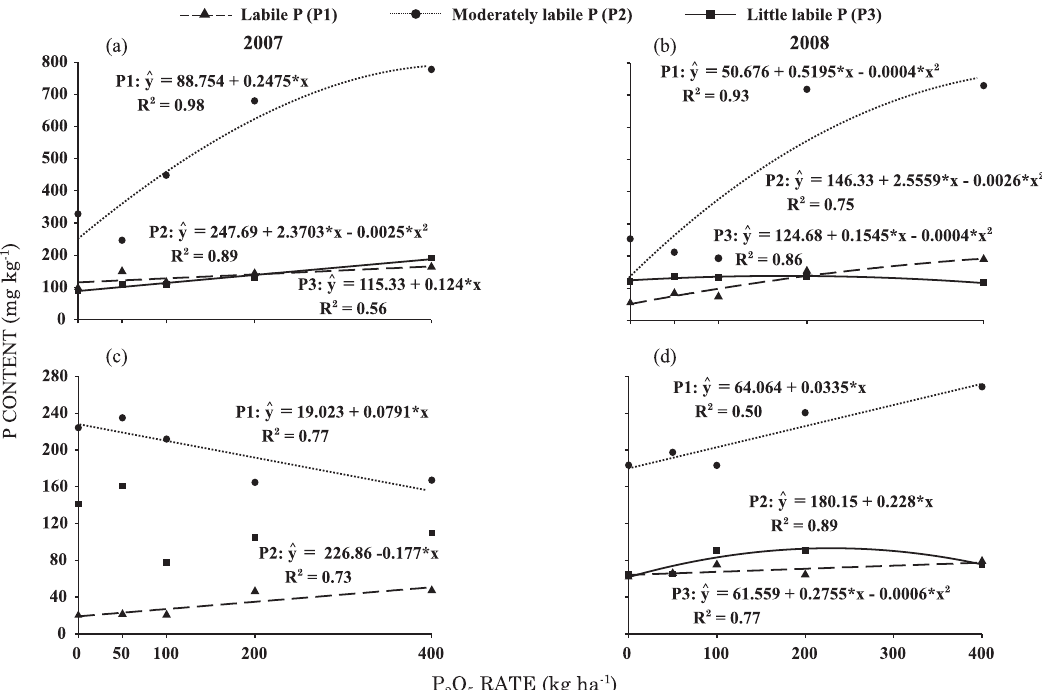
Figure 3. Contents of labile, moderately labile and low labile soil phosphorus in samples collected in two years (a and b = depth of 0–10 cm; c and d depth of 10–20 cm) by the extractors NaHCO NaOH 0.1 mol L -1 and NaOH 0.5 mol L -1 , respectively, in function of annual phosphorus application. * Significant by t test at 5